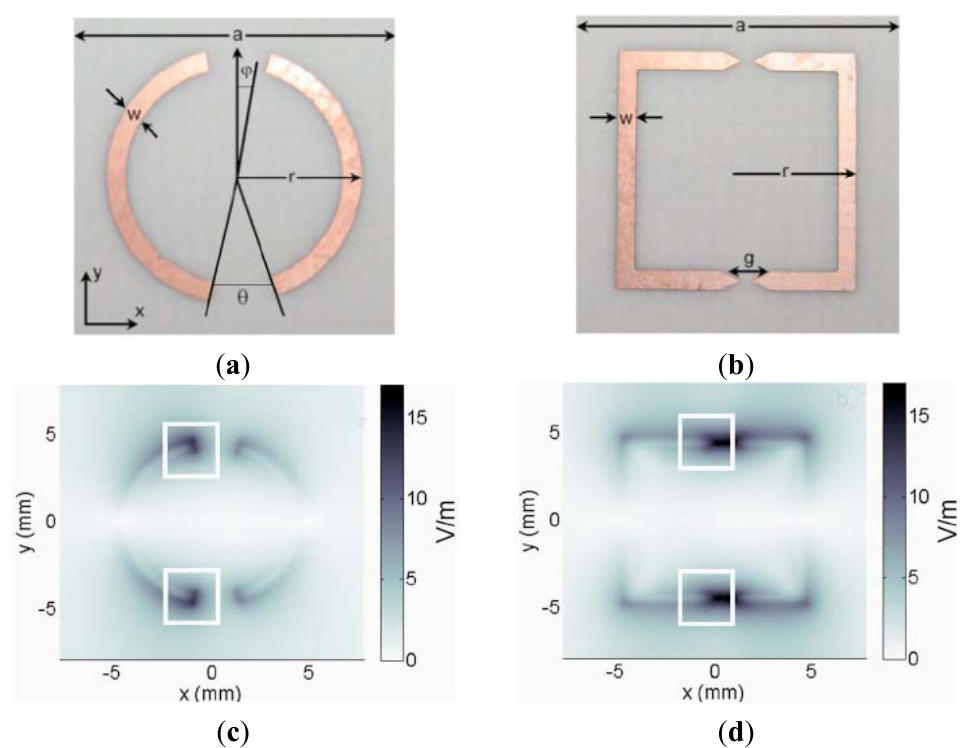
Figure 7. Layout of ( a ) the circular aDSR and ( b ) the rectangular aDSR with field confining tips, spatial field distribution in case of an excited field strength of 1 V/m for ( c ) the circular aDSR and ( d ) the rectangular aDSR with field confining tips